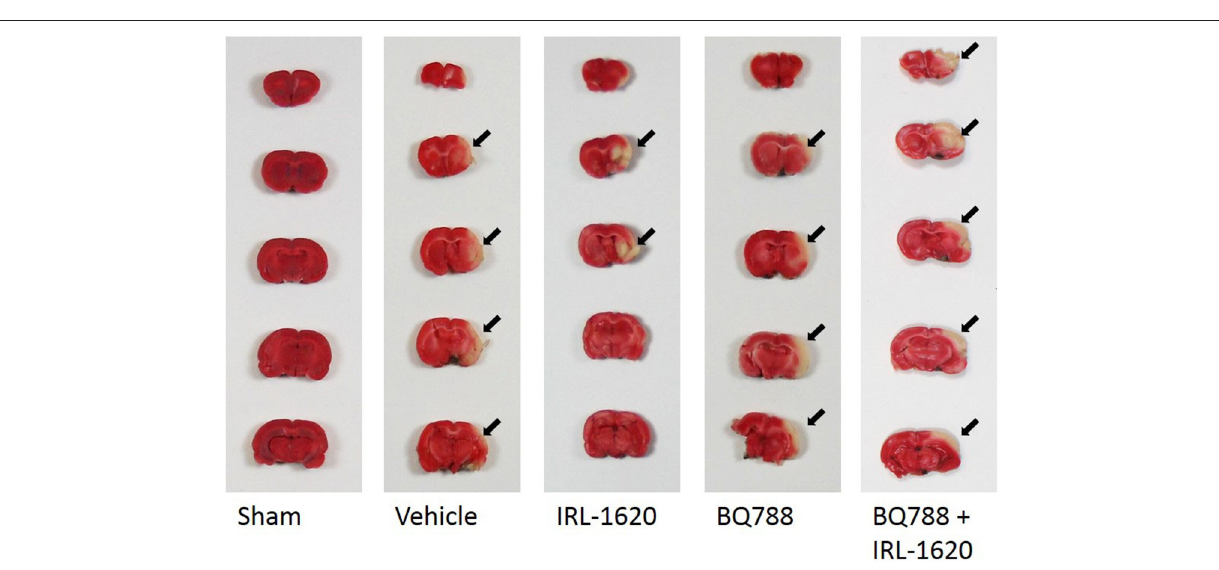
to the first 6 h of the onset of the stroke event, here